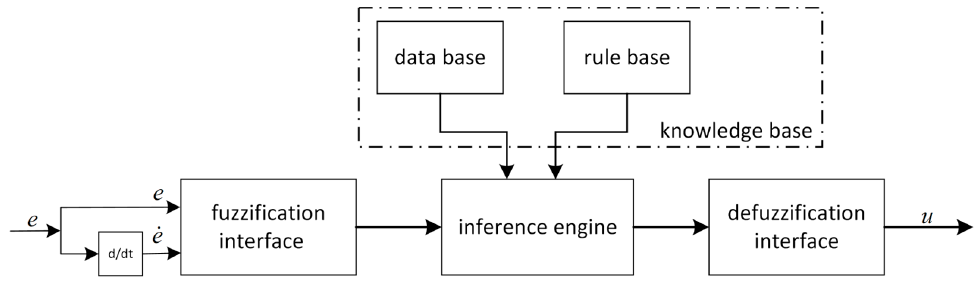
Figure 2. Block diagram of two-dimensional FLC.